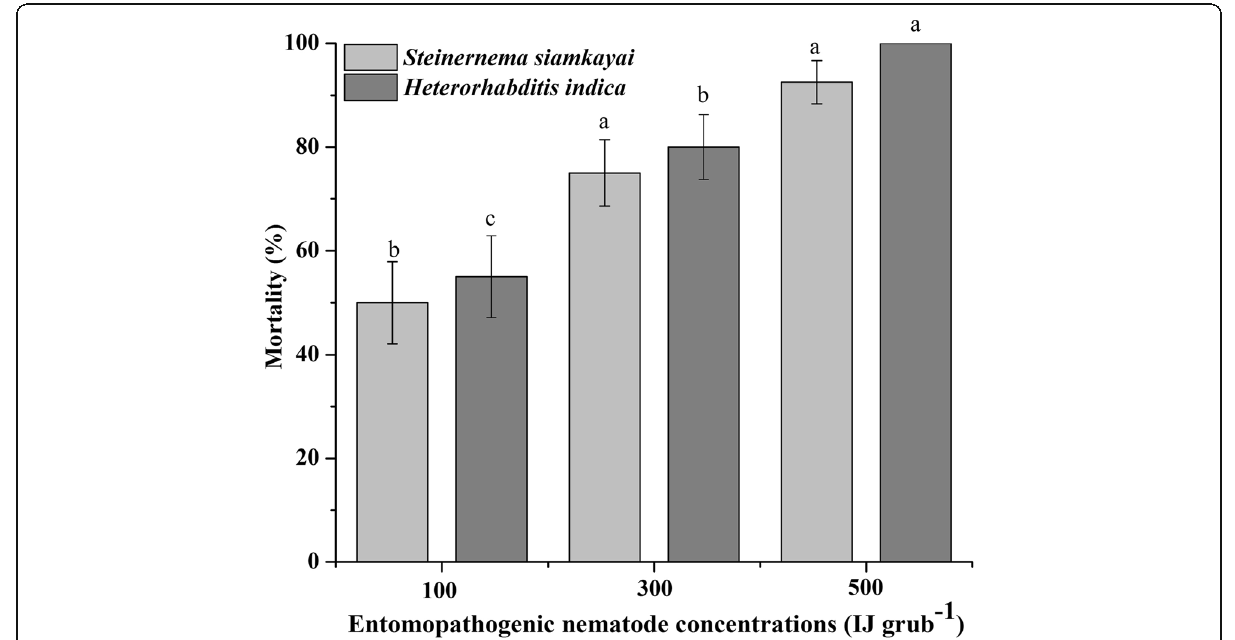
Fig. 4 Mortality (mean% ± SE) of 2 nd instar grub of Myllocerus subfaciatus Guerin at different concentrations of entomopathogenic nematodes, Steinernema siamkayai (IIVR JNC01 strain), and Heterorhabditis indica (NBAIIH38 strain) at 7 days after treatment. Different letters on the top of error bars indicate statistically different values for different nematode concentrations at ( P < 0.05) using Tukey ’ s test. Bars = standard error ( n =